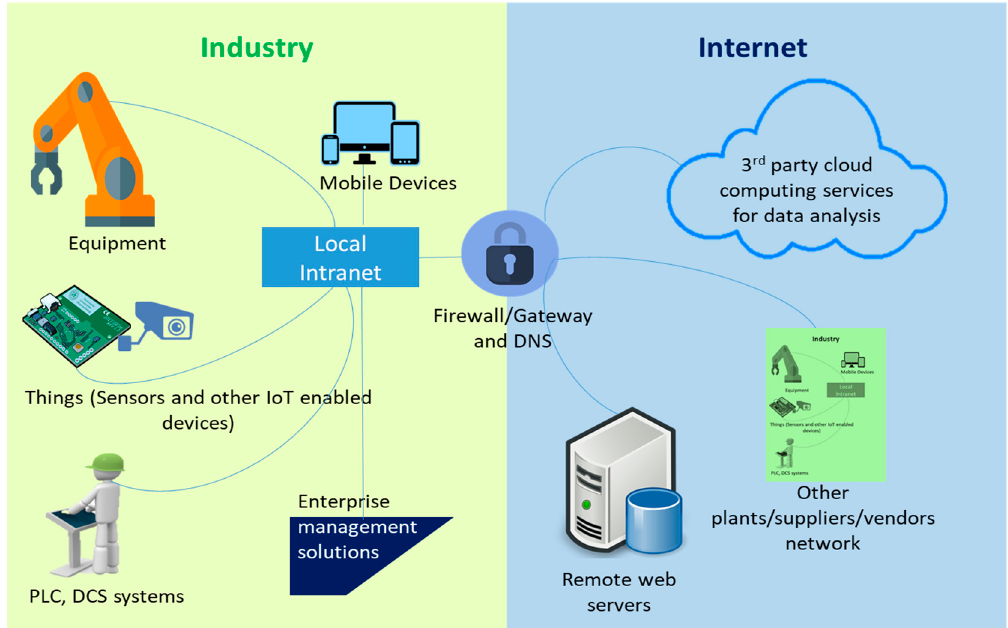
Figure 1. The industrial internet: the Internet of Things (IoT) enabled industry.